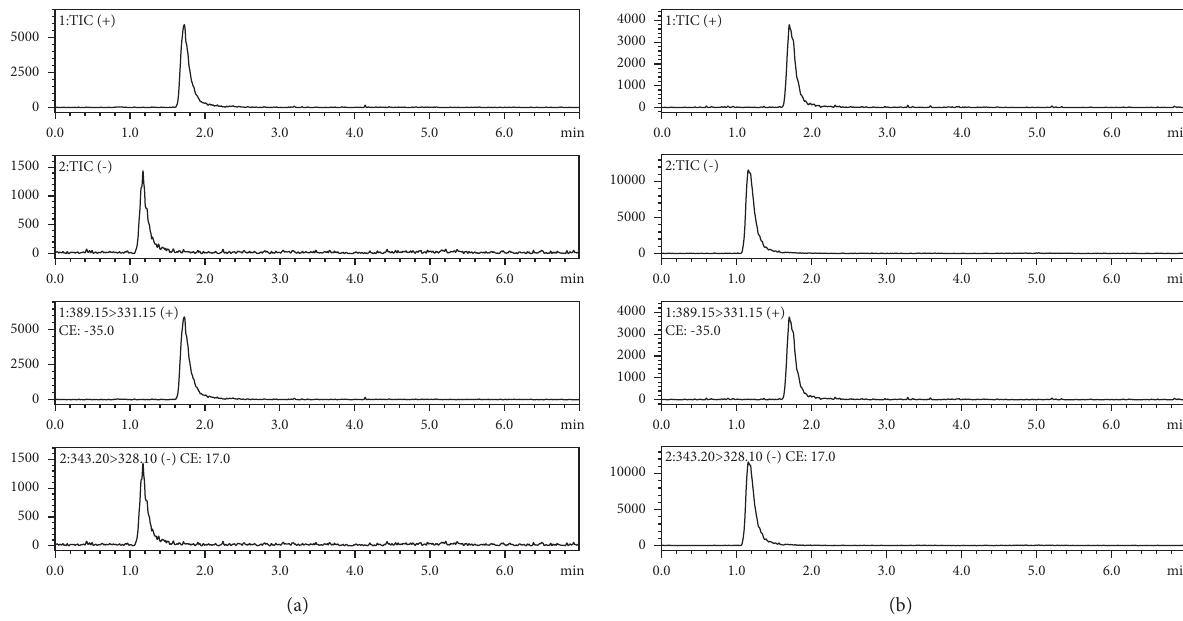
Figure 4: The MRM chromatograms of standard solution with 1ng/mL TMEA and IS in pure water and acetonitrile (a) and 0.1% formic acid water and acetonitrile